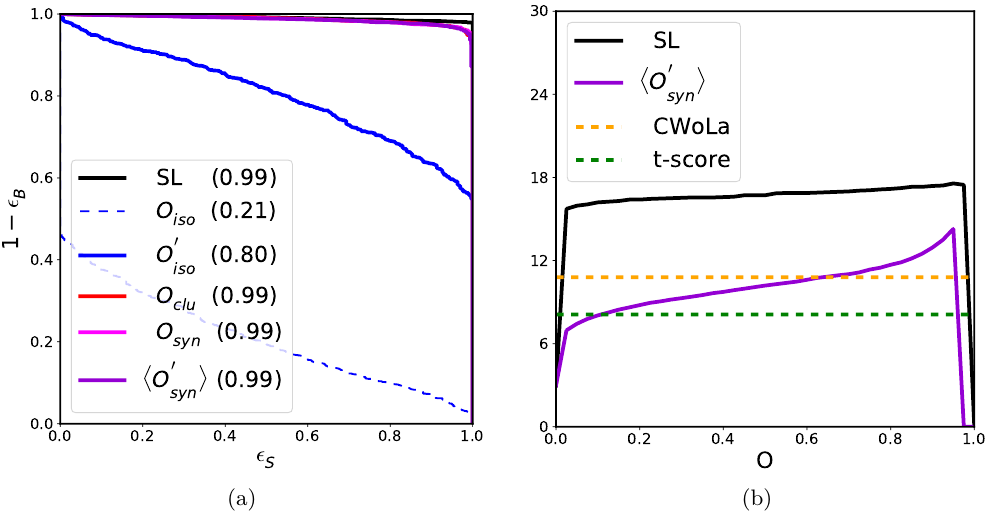
Figure 13 . (a) ROC curves and their AUC values (given in brackets) for the different novelty evaluators considered and (b) statistical significance as a function of the novelty score threshold (40 bins are defined), for the specific case of 3D resonant bump hunting studied in refs. [2, 32]. Here r = 0 . 8 is taken to define the signal-like sample S 0 for training O 0 0 significances obtained in [2, 32] are shown in the right panel while the SL performance is reported in